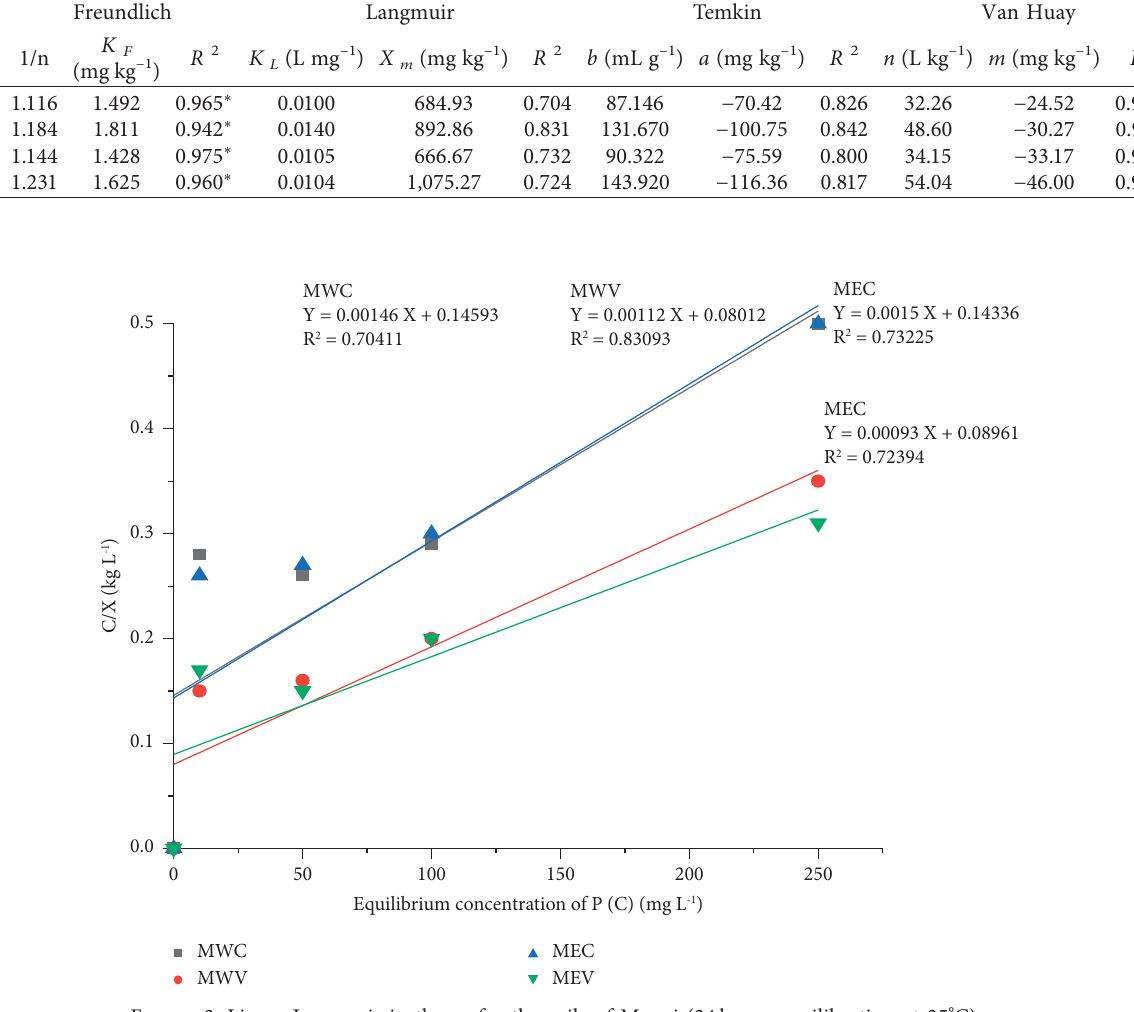
Table 2: Values of Freundlich, Langmuir, Temkin, and Van Huay constants and multiple coefficients determination ( R 2 ) of the soils.